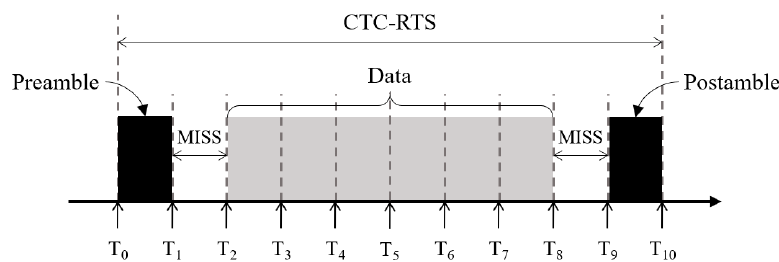
Figure 2. Constitution of the CTC-RTS frame.